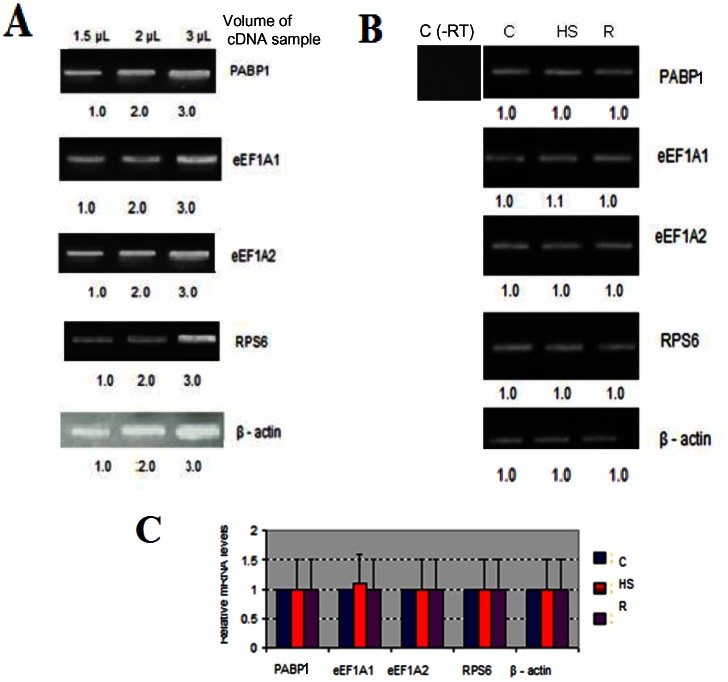
mRNA levels of PABP1, eEF1A and RPS6.Total cellular RNA from HeLa cells was isolated and the levels of specific mRNAs were determined by RT-PCR. Products of RT-PCR were analyzed by 1% agarose gel electrophoresis and quantified by scanning as described in materials and methods. Where applicable the relative expression values of all mRNAs were normalized by the β-actin mRNA level The values bellow each lane represent the relative abundance of each mRNA using an arbitrary scale where the level in control cells was considered to be 1.00. A) The dose response of the PCR reaction using 25 cycles of amplification for different mRNAs is shown. B) HeLa cells were grown to 40% cell confluence, heat shocked for 3 hours at 44°C and recovered for 24 hours at 37°C. Total cellular RNA from control, heat -hocked and following recovery from heat shock was analyzed. The C (-RT) lane indicates samples of amplification of RNA from control HeLa cells without reverse transcription. C) Experiments were repeated three times, and the averages are shown here as mean ± standard error.